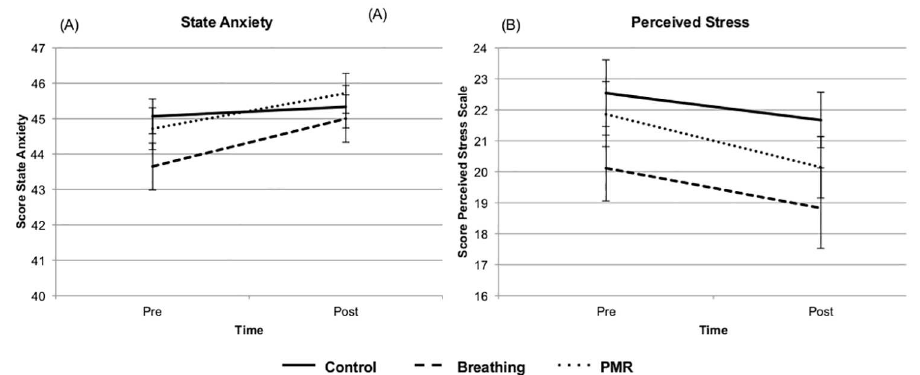
Fig 1. Effects of intervention on perceived anxiety and stress. (A) Perceivedanxiety significantly increasedover time, and (B) perceivedstress significantly decreased, but there were no significanteffects of intervention type on changein scores over time.